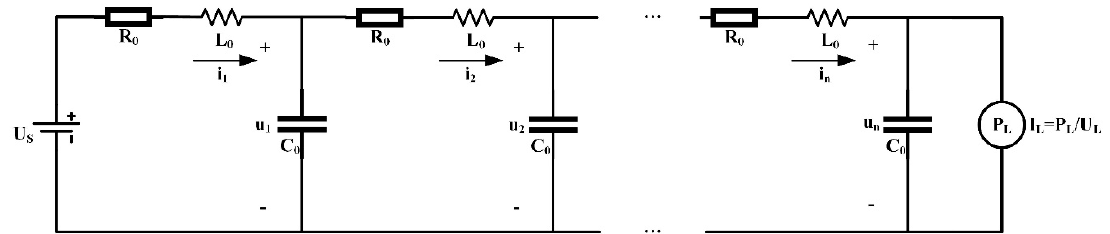
Figure 5. A simplified model of a single-node CSO undersea DC power system.